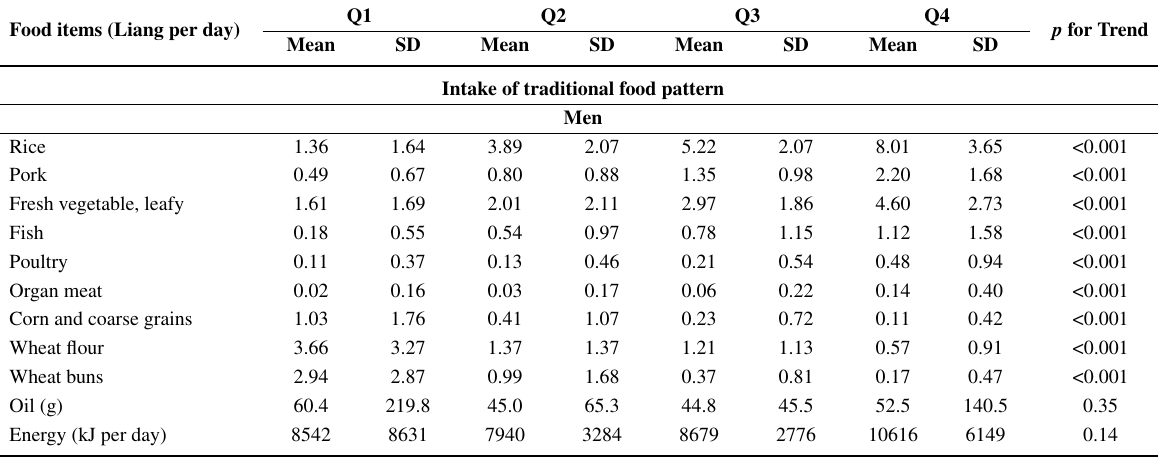
Figure 1. Factor loadings for two food patterns among older Chinese people ( n = 2745) *. (* Factor loadings of >|0.20| represent the foods which most strongly related to the identified factor). Table 2. Food intakes across qualities of traditional and modern dietary pattern for men and women.